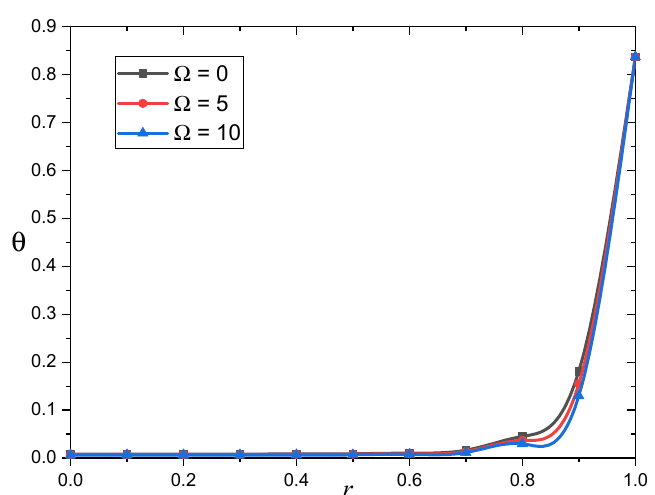
Figure 7. The temperature variation (cid:2016) for different rotation parameter Ω . Figure 7. The temperature variation θ for different rotation parameter Ω